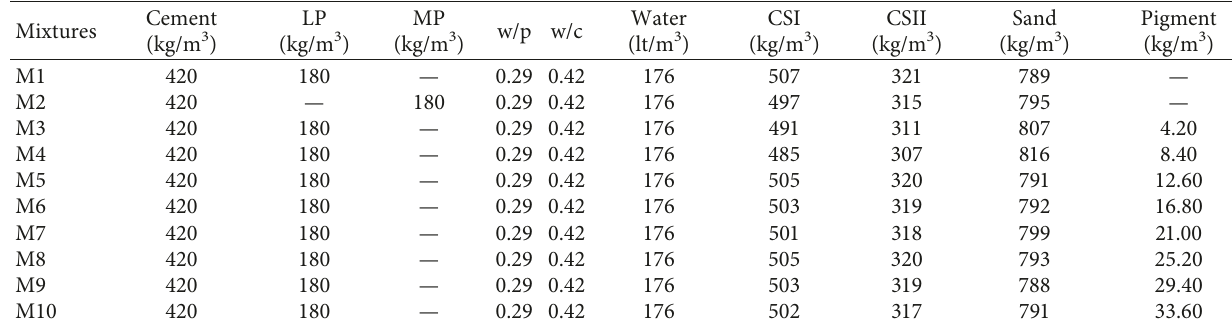
Table 3: Mix proportions of SCC